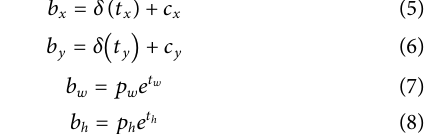
FIGURE 1 Flow of the foreign body intrusion identi fi cation system in the power distribution